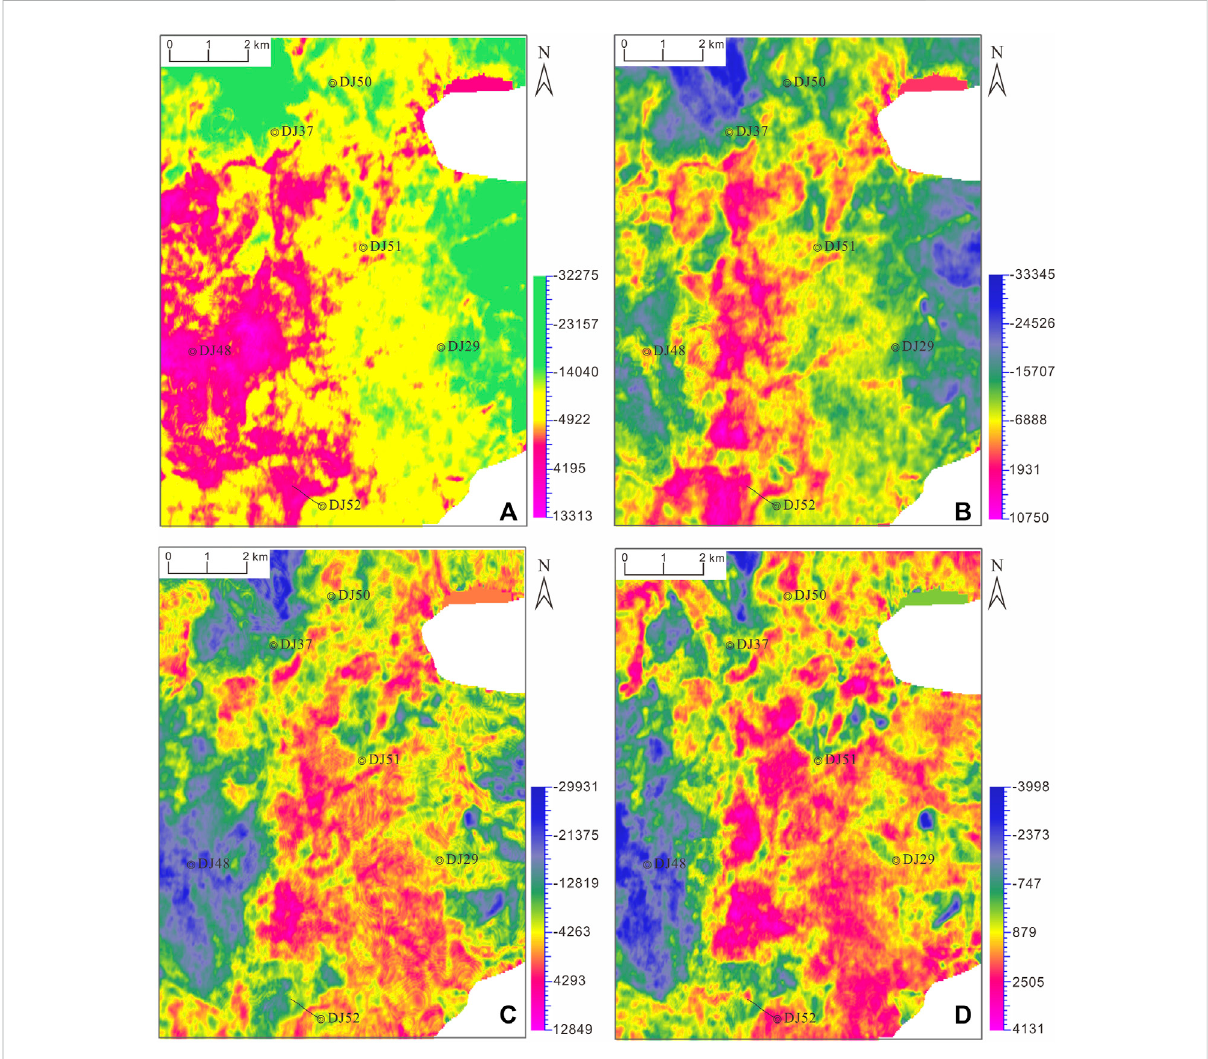
FIGURE 7 Minimum amplitude attributeplanedistribution of eachsection intheShan-2Lower Sub-member intheeasternOrdos Basin: (A) Section 4; (B) Section 3; (C) Section 2; (D) Section